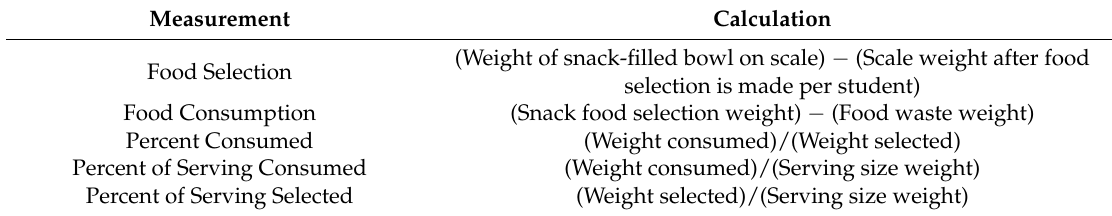
Table 6. Calculations made to compare the selection and consumption. All weight measurements were in grams and calculated for each student and food